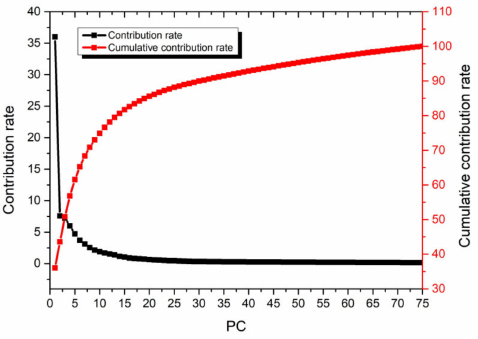
Figure 5. The contribution rate of each principal component and their cumulative contribution rate of the principal